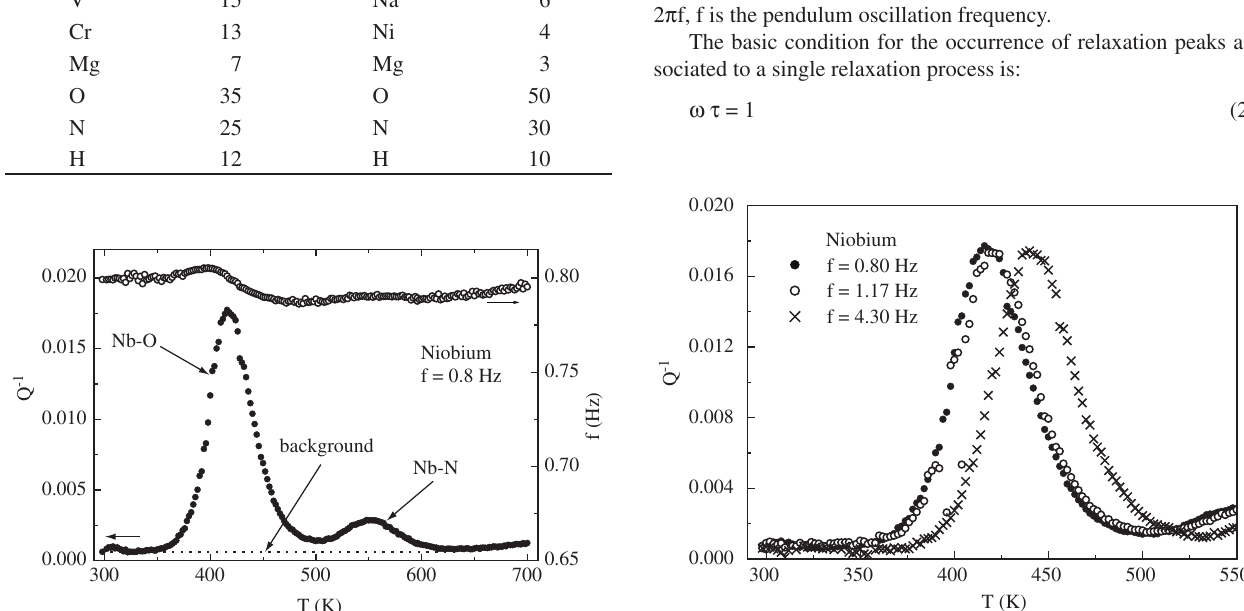
Figure 1. Anelastic relaxation spectrum of Nb measured with frequency of 0.8 Hz.